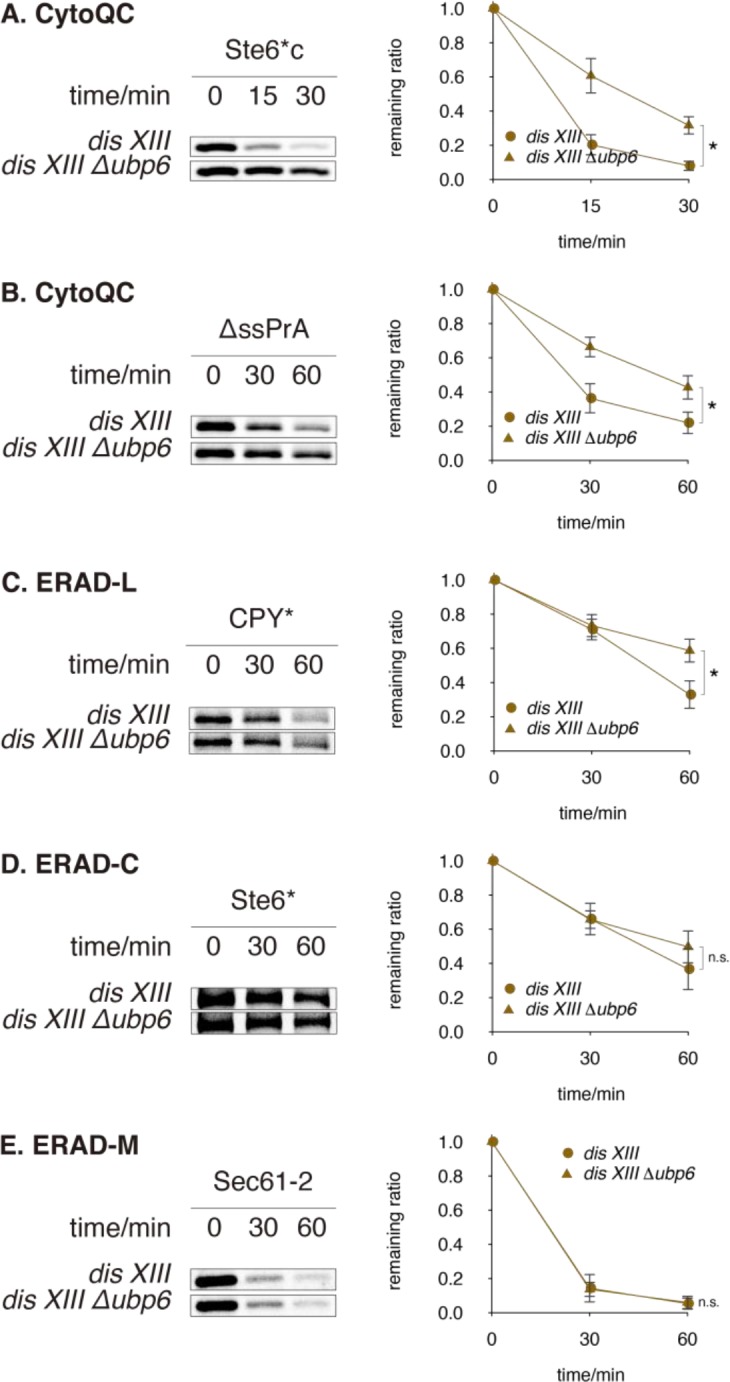
Δubp6 delays QC in dis XIII aneuploid strain.(A and B) Degradation of misfolded cytosolic proteins in dis XIII and dis XIII Δubp6. (C—E) Degradation of misfolded ER proteins. Substrates were pulsed-chased as in Fig 2.